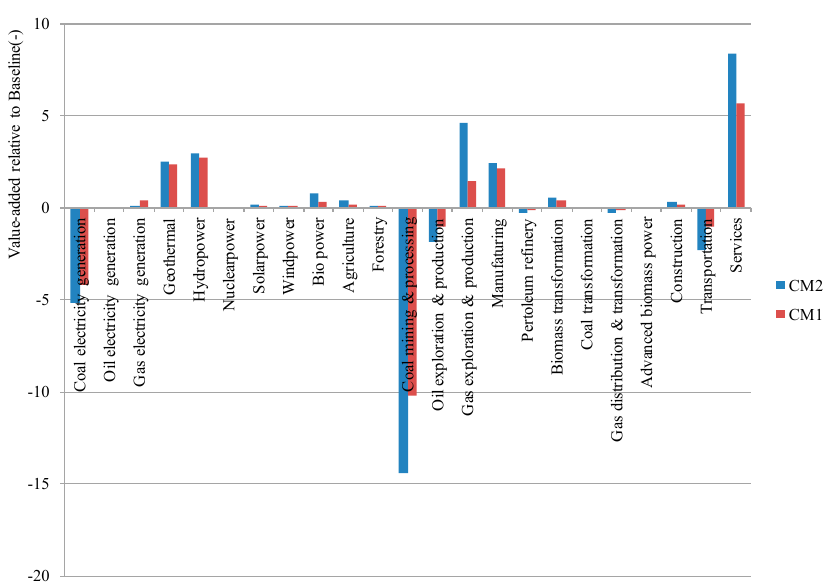
Figure 10. Share of value-added output.